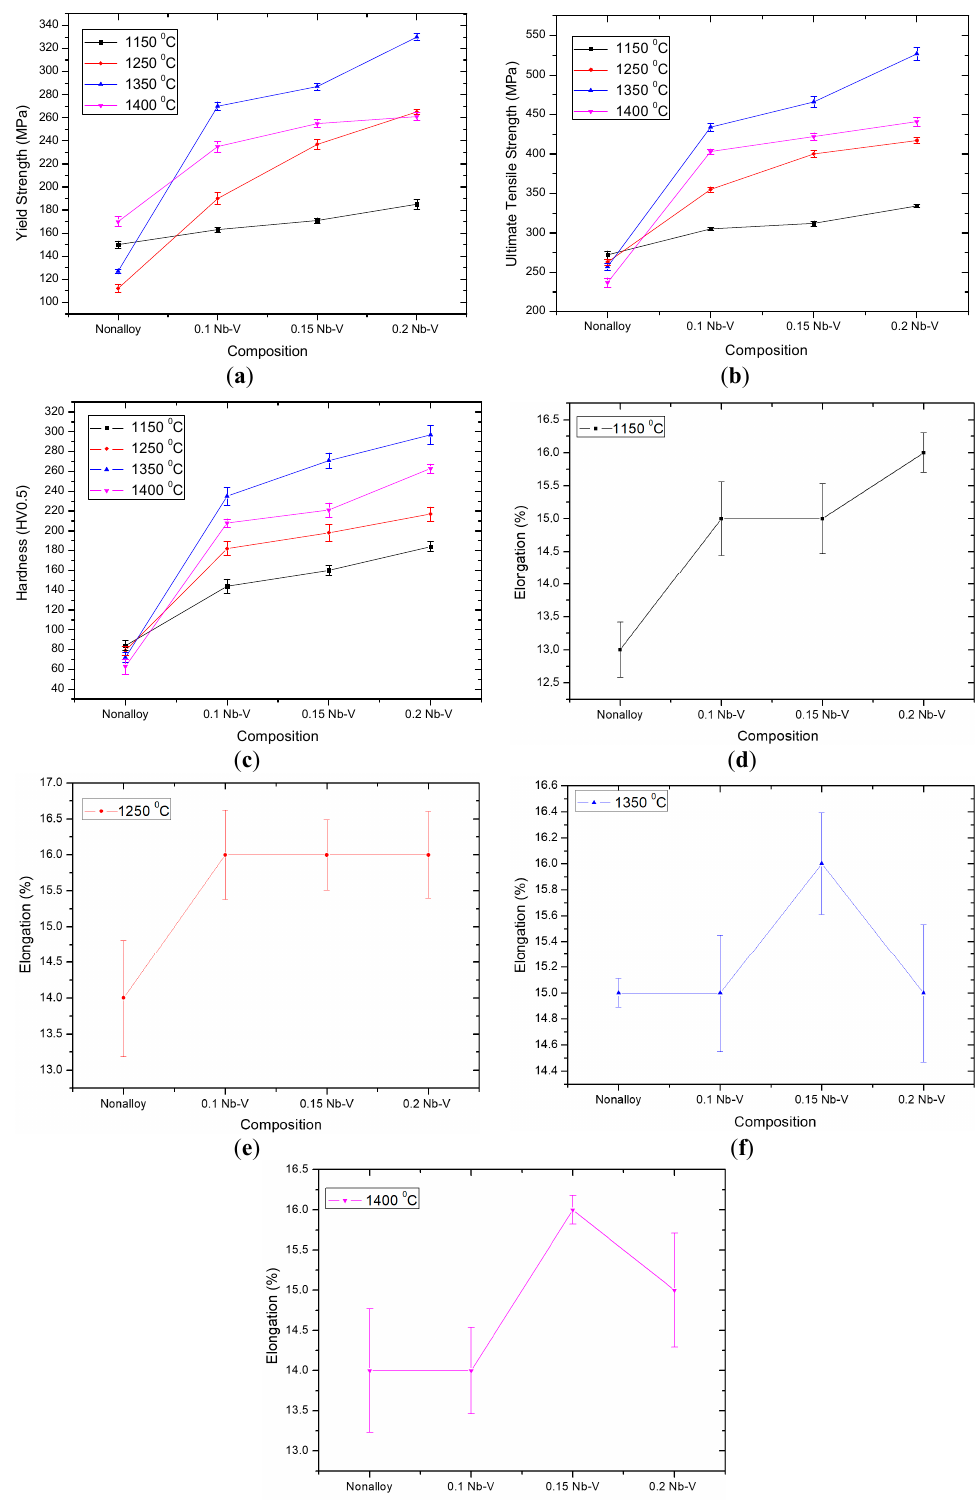
Figure 5. Mechanical properties of the PM steel and microalloyed PM steels at different percentages of Nb-V content and different temperatures: ( a ) yield strength (MPa), ( b ) ultimate tensile strength (MPa), ( c ) hardness (HV0.5) and elongation % (( d ) 1150 °C, ( e ) 1250 °C, ( f ) 1350 °C and ( g ) 1450 °C).